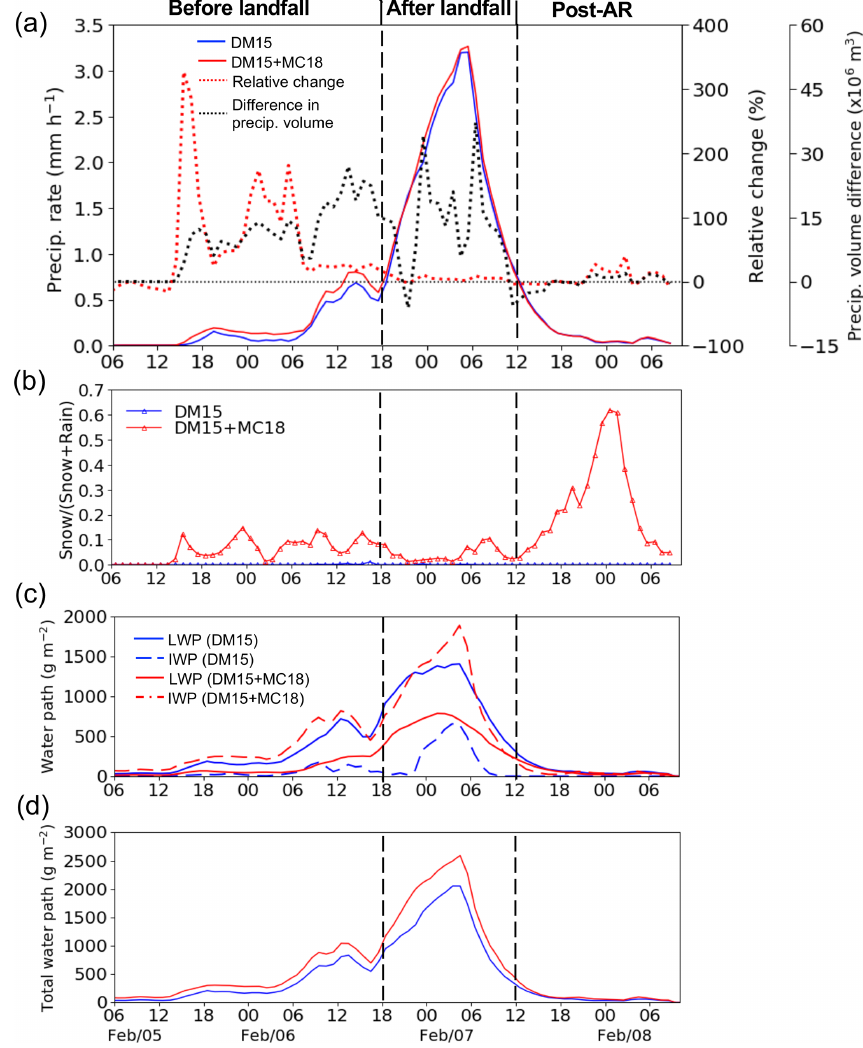
Figure 7. Time series of (a) precipitation rate (solid lines, left y axis), (b) ratio of snow precipitation (i.e., snow / (snow + rain) in mass mixing ratio) at the lowest model level, (c) LWP (solid lines) and IWP (dashed lines) for DM15 (blue) and DM15 + MC18 (red), and (d) total condensate water path (TWP). The plot (a) also shows the percentage changes in precipitation rate (dotted red line, second y axis) and the absolute difference in precipitation volume (dotted black line, third y axis) from DM15 to DM15 + MC18. The dashed vertical lines divide the three AR